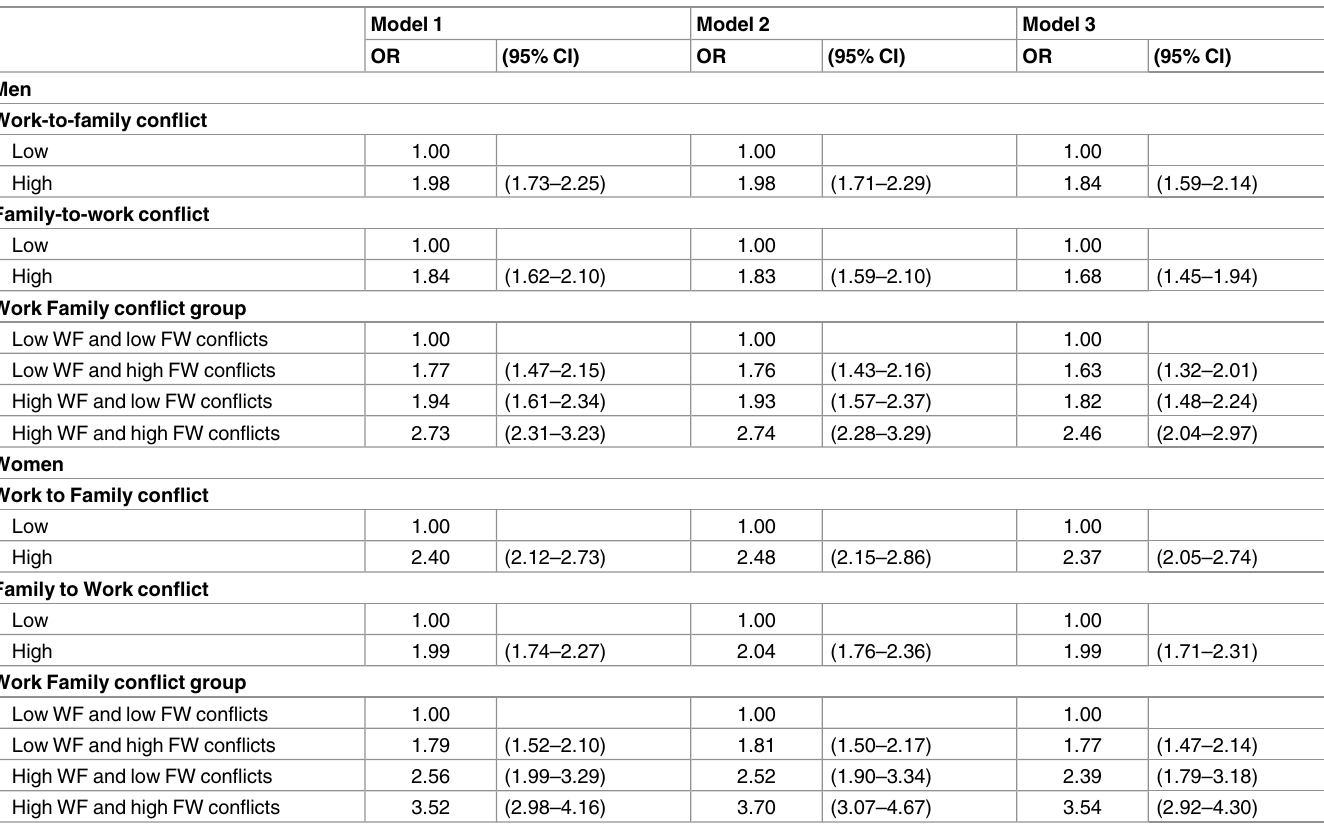
Table 2. Odds ratios (OR) for poor self-rated health associated with work–family conflict, separately by